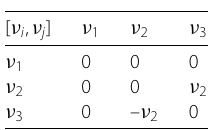
Table 1 The commutator table of Eq. (1)